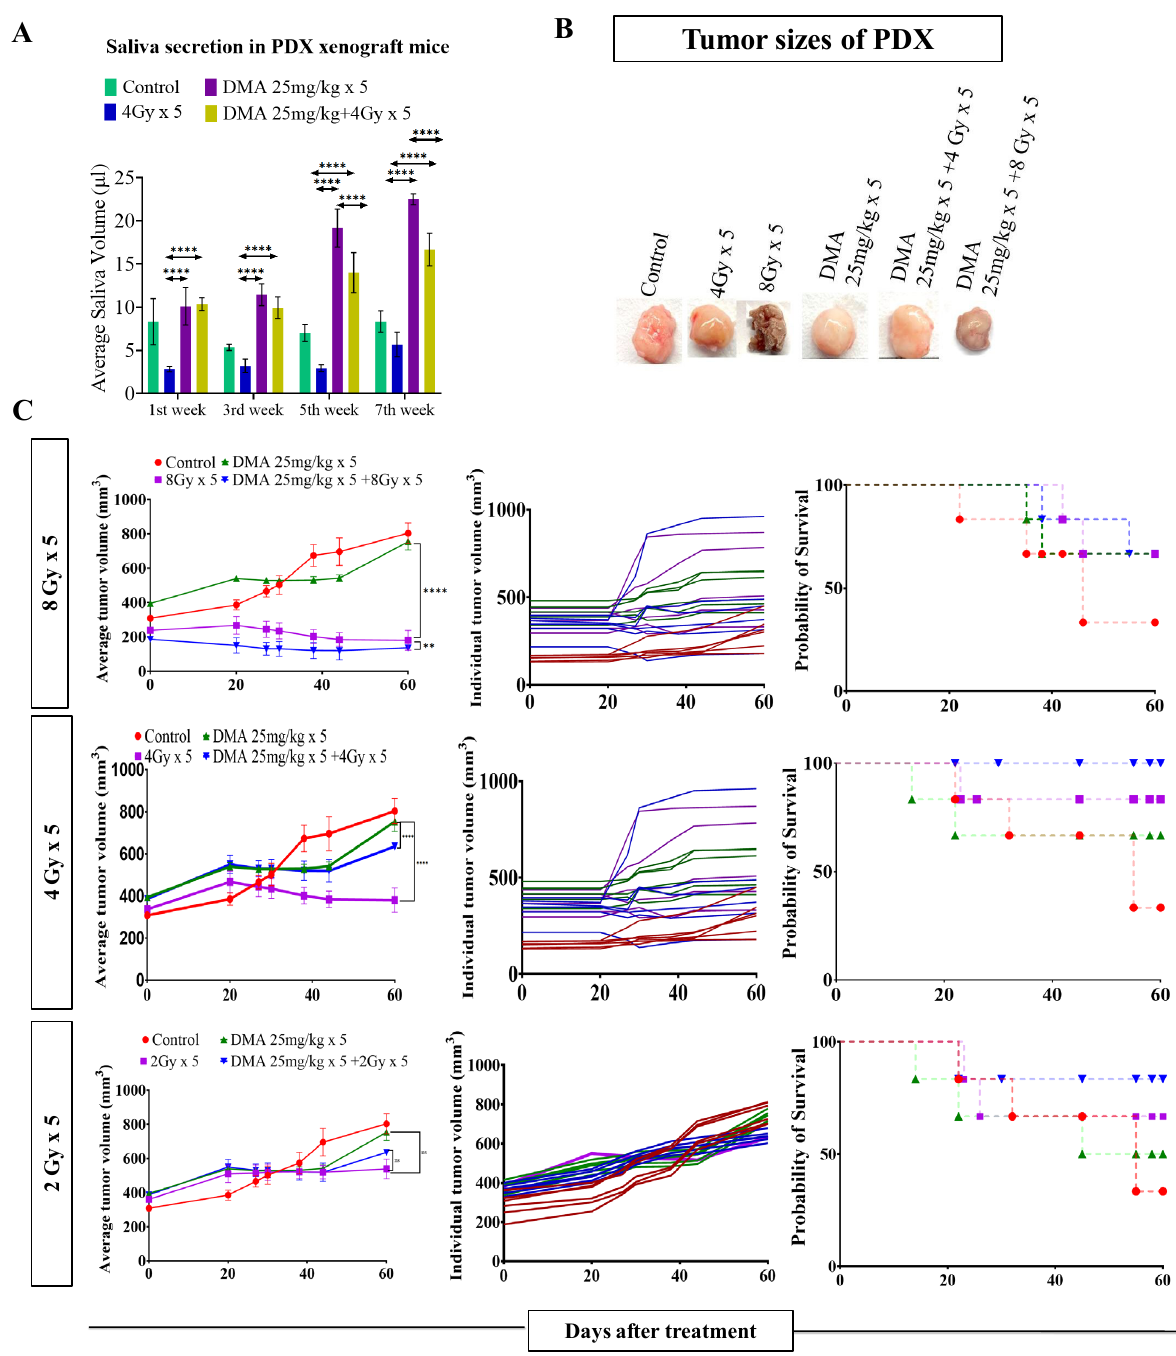
Figure 3. DMA restores saliva secretion and causes the enhancement of radiation-induced tumor growth delay (TGD) with an increasing radiation dose per fraction in the PDX mouse model. Measurement of stimulated saliva secretion in ( A ) the first, third, fifth, and seventh week in the PDX model with ( B ) a pictorial depiction of the tumor sizes after the completion of the study (after 60 days from the start of the treatment). ( C ) The PDX was treated with IR schedules of 8 Gy × 5, 4 Gy × 5, or 2 Gy × 5 fractions alone and in combination with DMA given once per day for 5 days, 2 h before irradiation. Average tumor volumes (left column), individual tumor volumes (middle column), and Kaplan–Meier analysis for survival are shown. All animal cohorts contained n = 6 animals per group. Data were analyzed using two-way ANOVA followed by Tukey’s multiple comparisons. p -values at ** < 0.005 and **** < 0.00005 indicate statistical